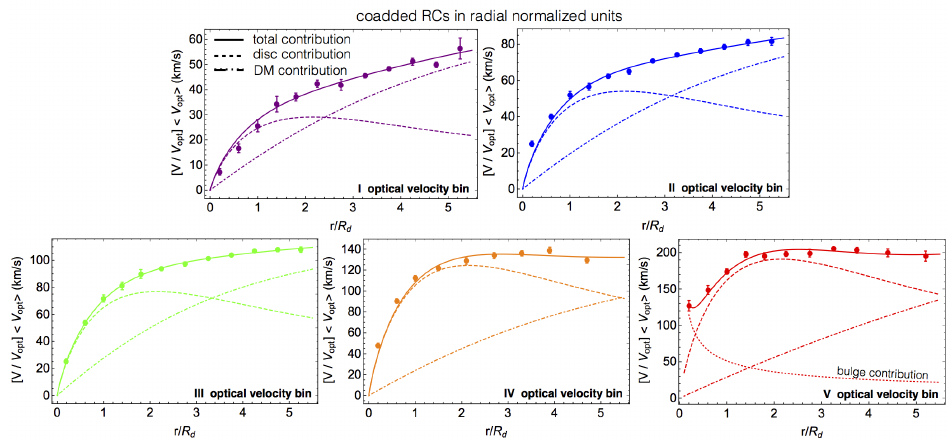
Figure 17. The LSB-URC, i.e., the best-fit models (solid lines) of the coadded LSB-RCs (points with errorbars). The dashed, dot-dashed, dotted lines indicate the separate stellar disc, DM halo, stellar bulge contributions. Image reproduced from [38].